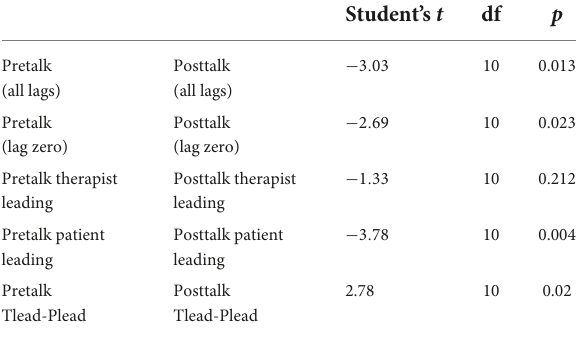
TABLE 4 Results of parametric paired sample T